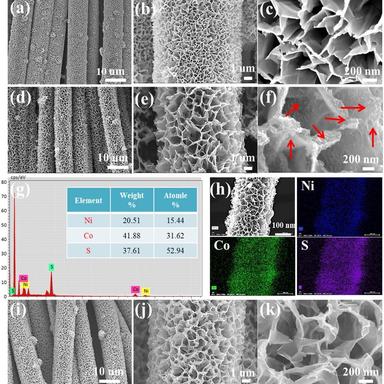
SEM images of the Ni-Co precursor/CC (a–c) and NiCo2S4/CC (d–f) at different magnifications. (g) EDX spectrum for NiCo2S4/CC. (h) SEM image and corresponding EDX elemental mapping images for Ni, Co, S of NiCo2S4/CC. (i–k) SEM images of the NiCo2O4/CC at different magnifications.